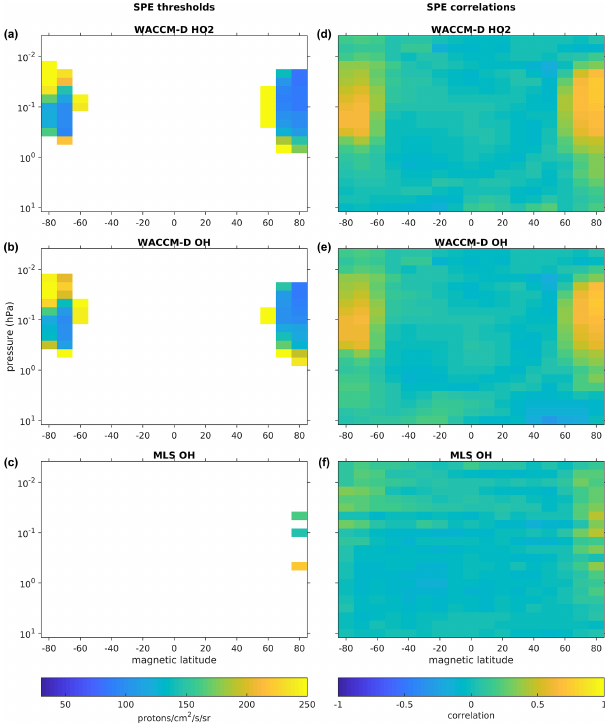
Figure 8. Daytime SPE indicator thresholds (a–c) and corre- sponding correlations (d–f) . WACCM-D HO 2 (a, d) , WACCM-D OH (b, e) , and MLS OH (c, f) .